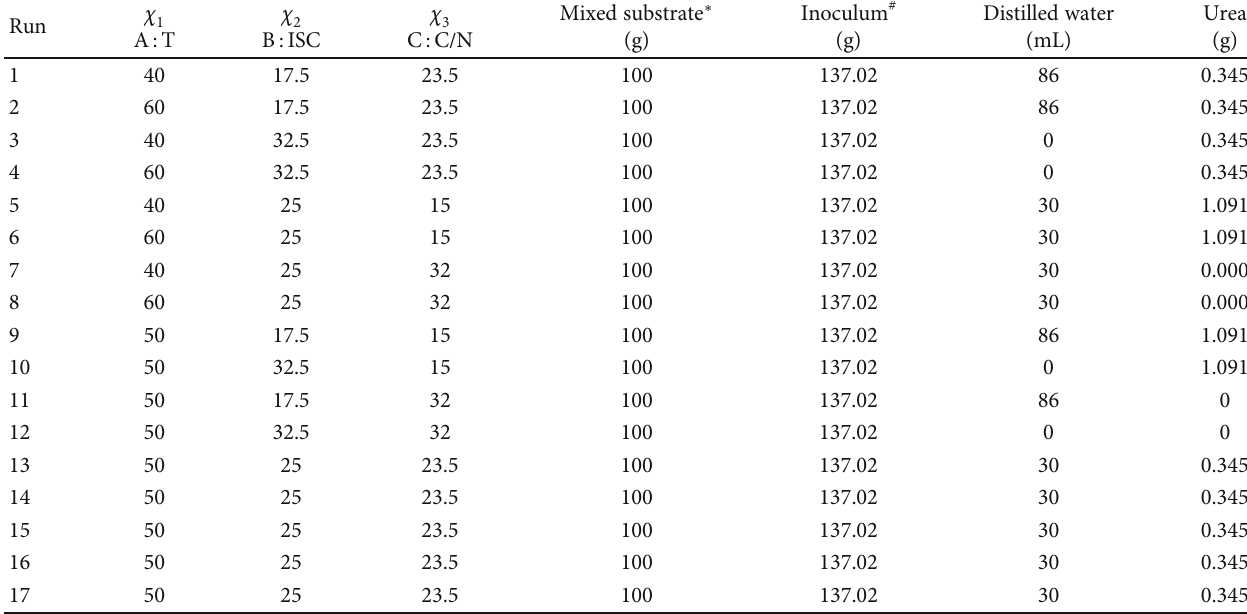
Table 2: Three-level-three-factor Box – Behnken design for SS-AD of corn straw, cattle manure, and vegetable waste. χ 1 Run